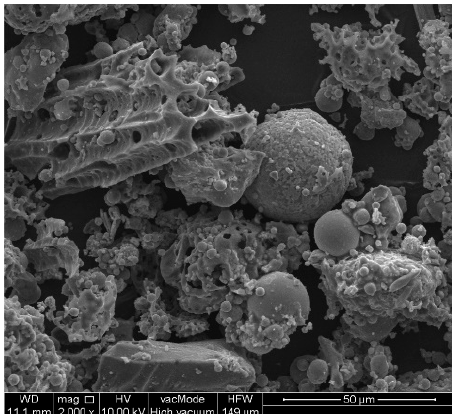
6.8%. The particle size distribution curves for Na ‐ P1 and Na ‐ P1(C) were bimodal, with